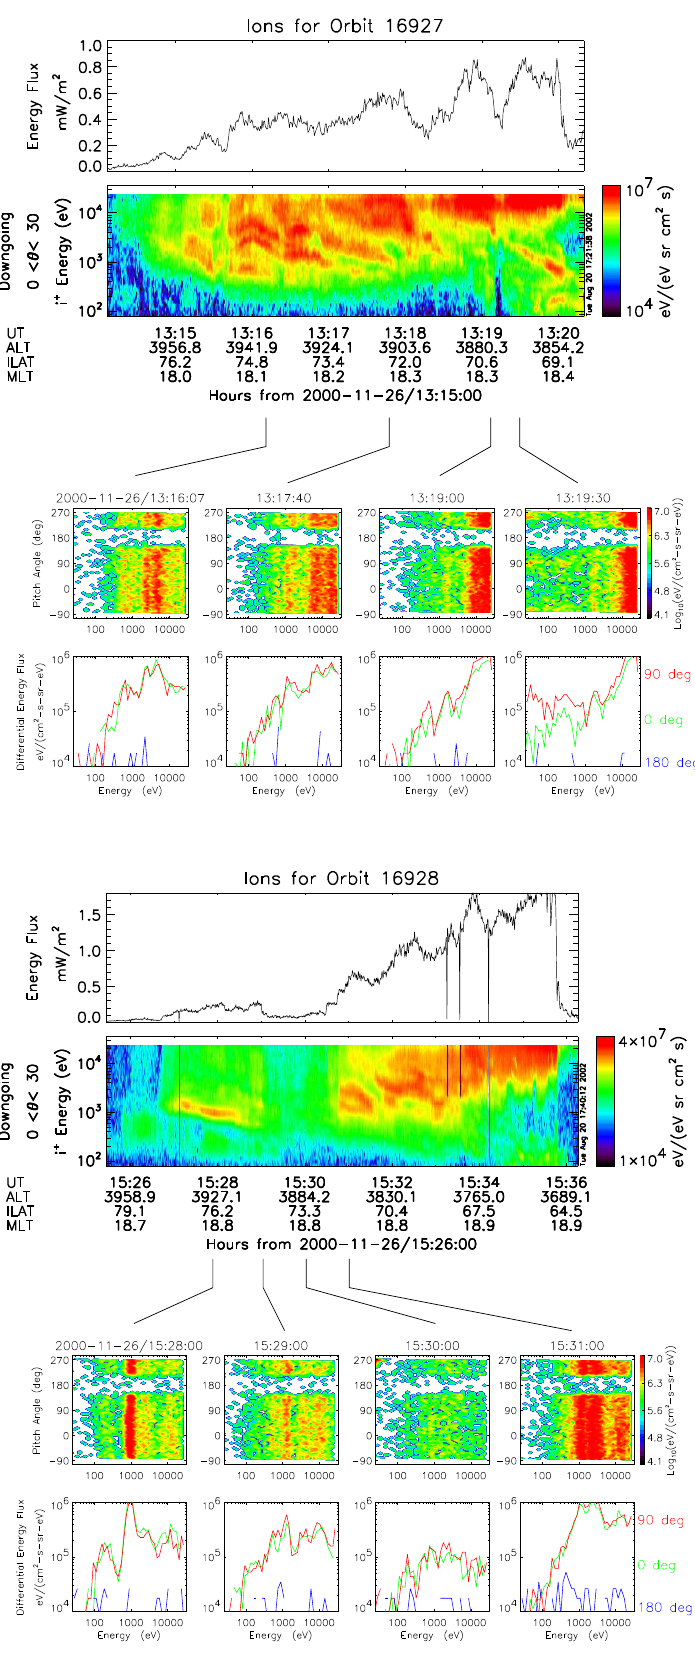
Fig. 5. (top panels) Energy flux of downgoing ions and energy spectro- gram from FAST at 15:28 UT. (bottom panels) Energy flux as a function of ion pitch-angle vs. energy, and as a func- tion of energy for three different pitch- angles. The times are marked in the top